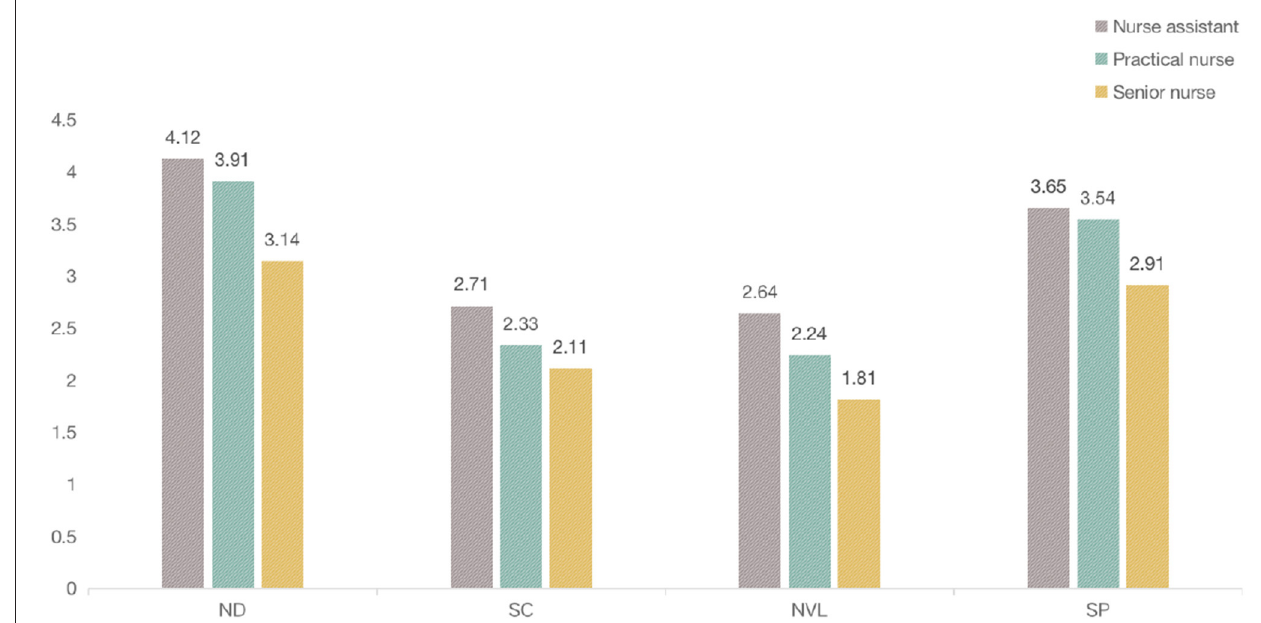
FIGURE 6 | Importance of environmental factors on psychological fatigue.